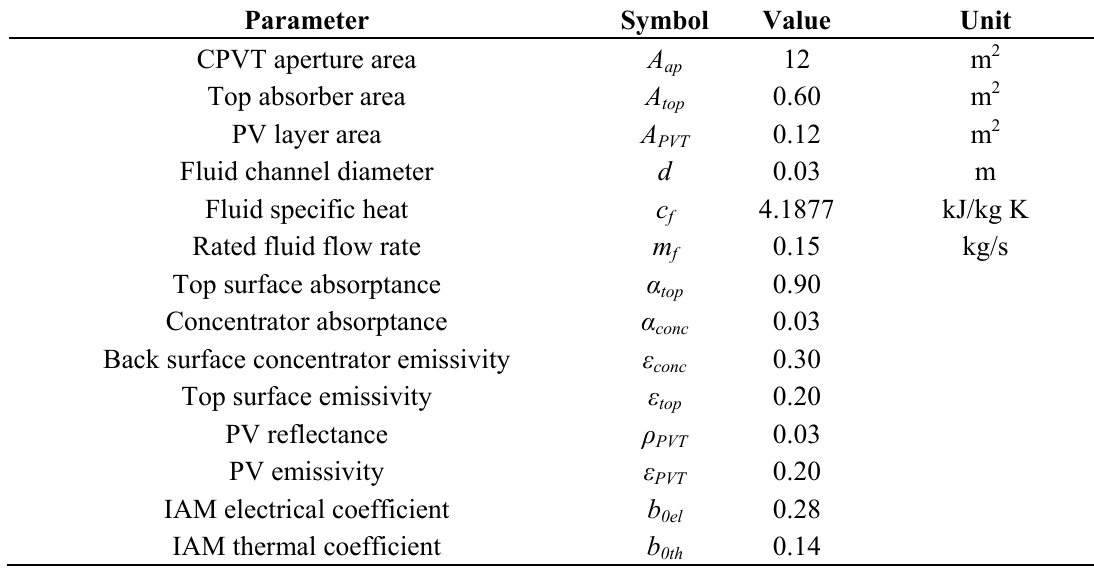
Table 1. CPVT design